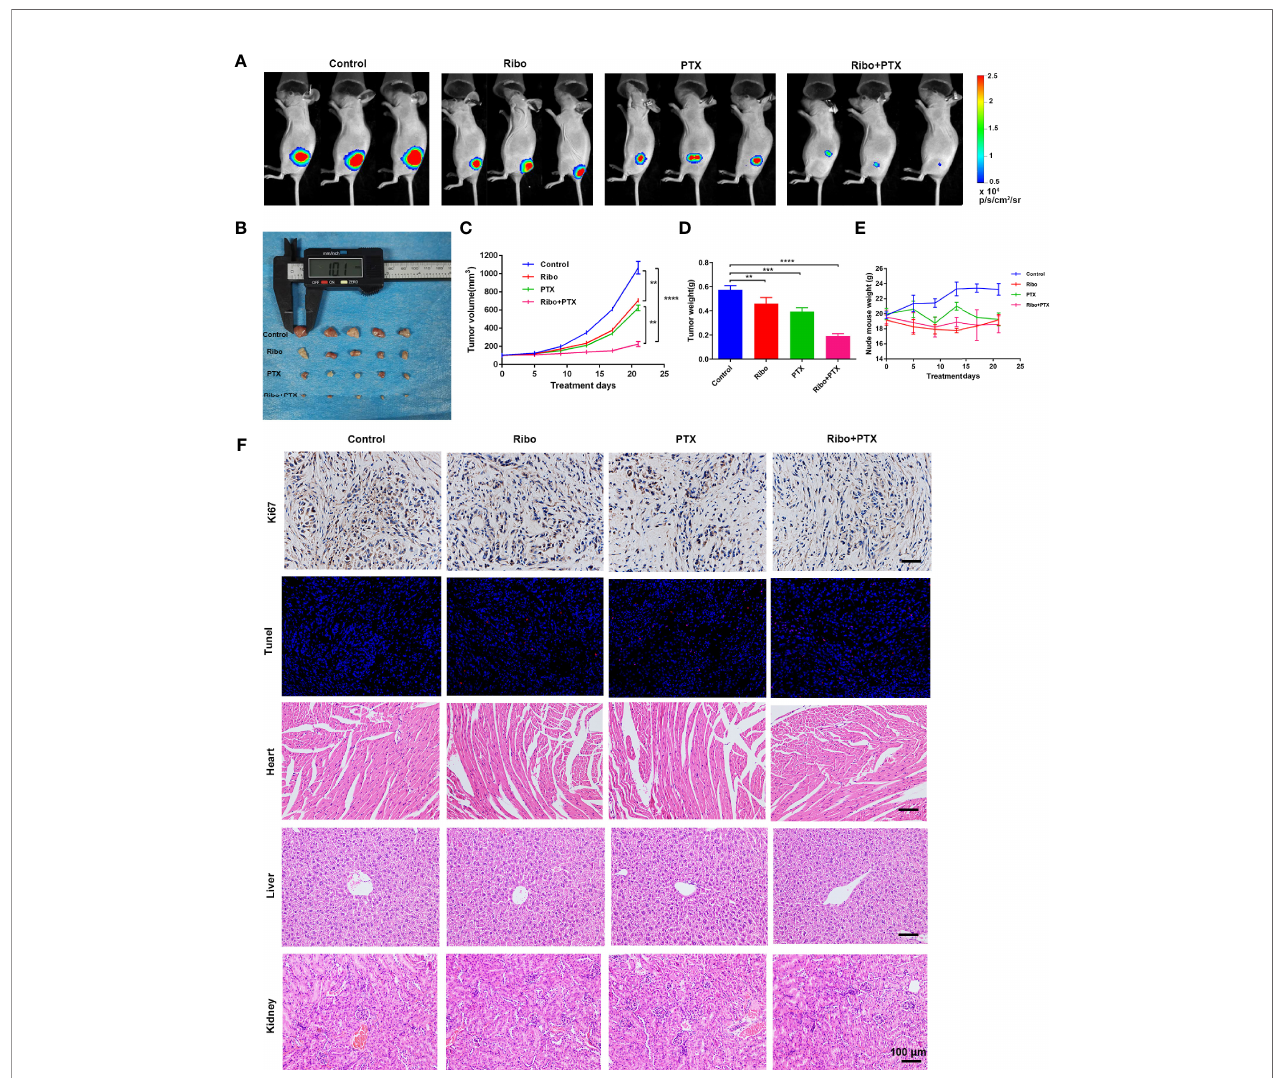
FIGURE 6 | The therapeutic effect of ribociclib plus pemetrexed in a xenograft nude mouse model. (A) Representative fl uorescence images of luciferase signals captured from subcutaneous tumors are shown. (B – D) The change of tumor volume and tumor weights (n = 5 mice per group). (E) The effect of body weight. Data are presented as mean ± SD of triplicate experiment (**p < 0.01, ***p < 0.001 and ****p < 0.0001). (F) Representative panels of immunohistochemical and HE staining. The scale bars represent 100 m m. SD, standard deviation; HE, hematoxylin and